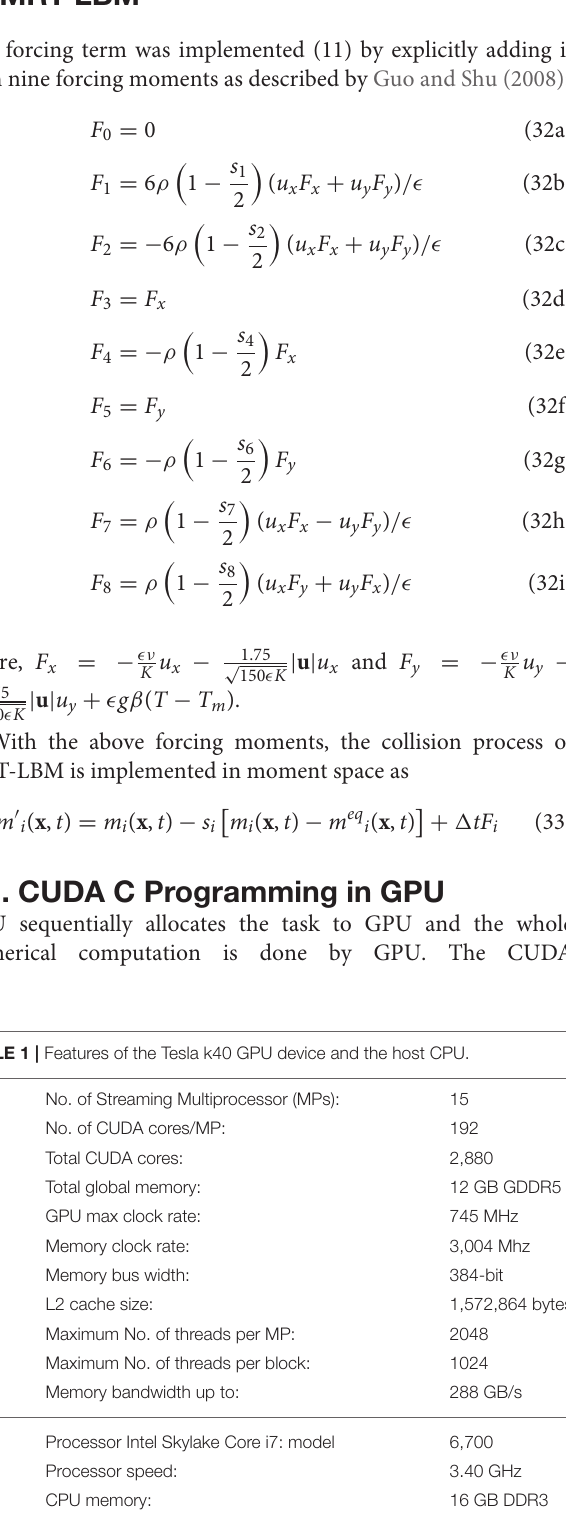
FIGURE 3 | CUDA programming: grid of thread blocks (Source: